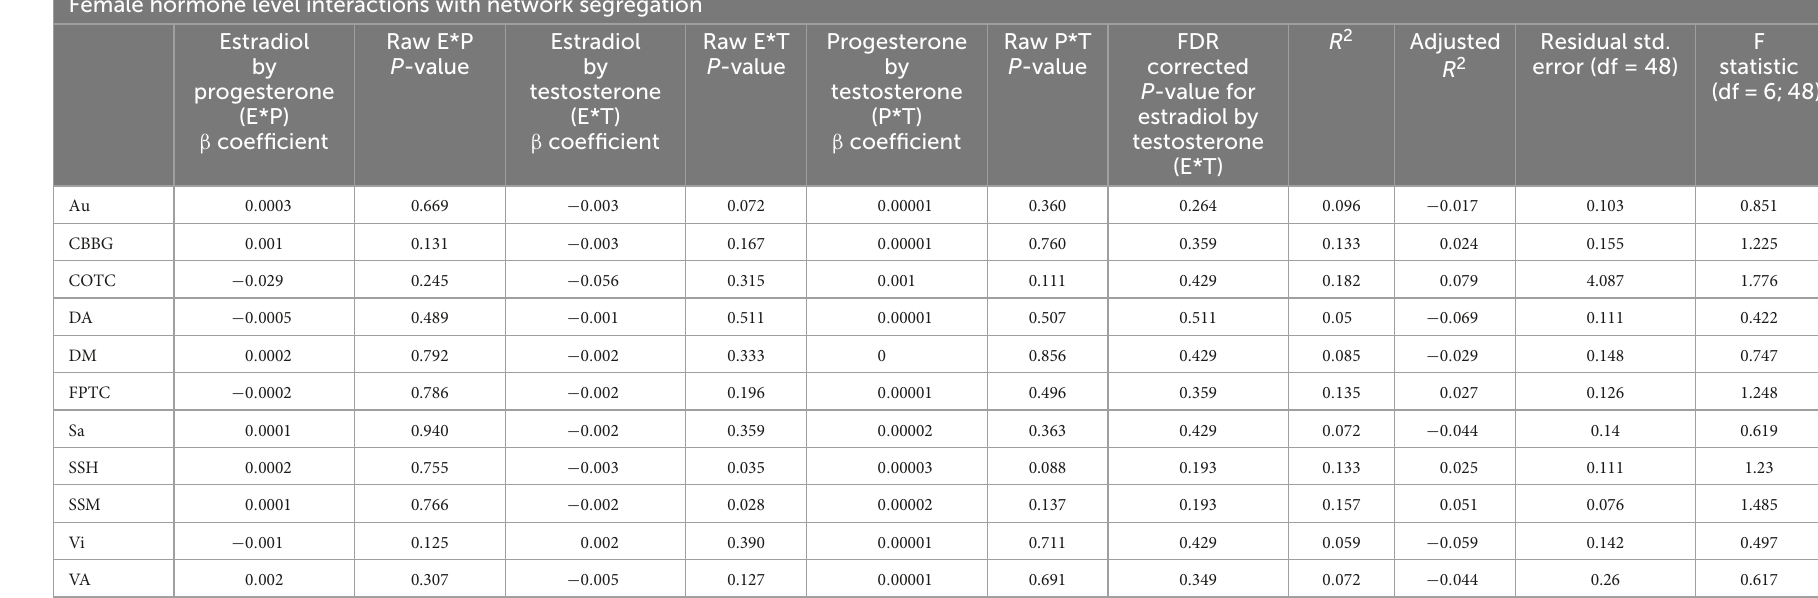
Raw p -valuesandFDRcorrected p -valuesareincluded.FDRcorrectionwasonlyperformedifraw p -valuewas <